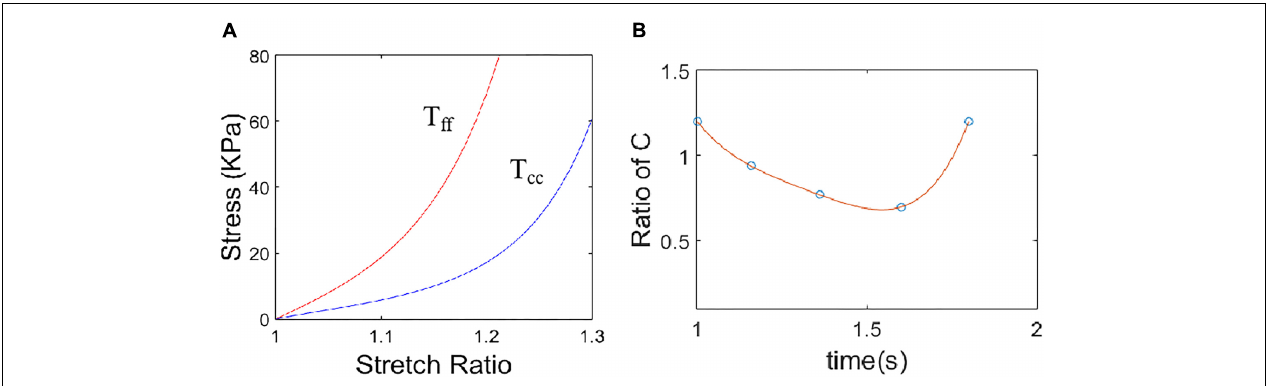
FIGURE 3 | Material stress-stretch curves for a baseline model with right ventricular apex (RVA) pacemaker. (A) Baseline material stress-stretch curves, T ff : stress in fiber direction, T cc : stress in circumferential direction of the fiber. (B) Stiffness variation in a cardiac cycle for a sample region of the model with RVA pacemaker. Stiffness variation was realized by adjust C values in Eq. (12).